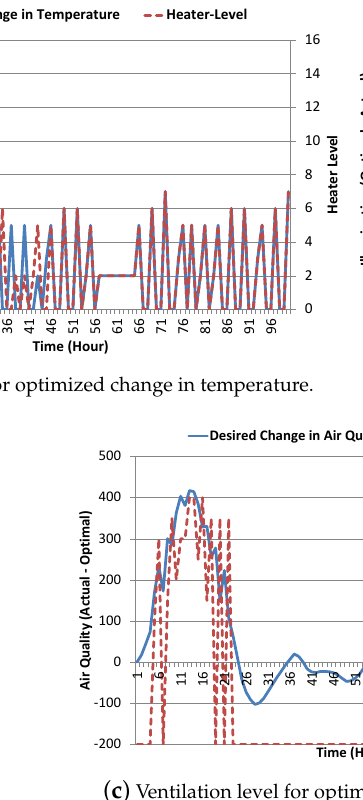
Figure 8. Change in actuators’ level for the optimized change in the indoor parameters: first four days (100 h) of